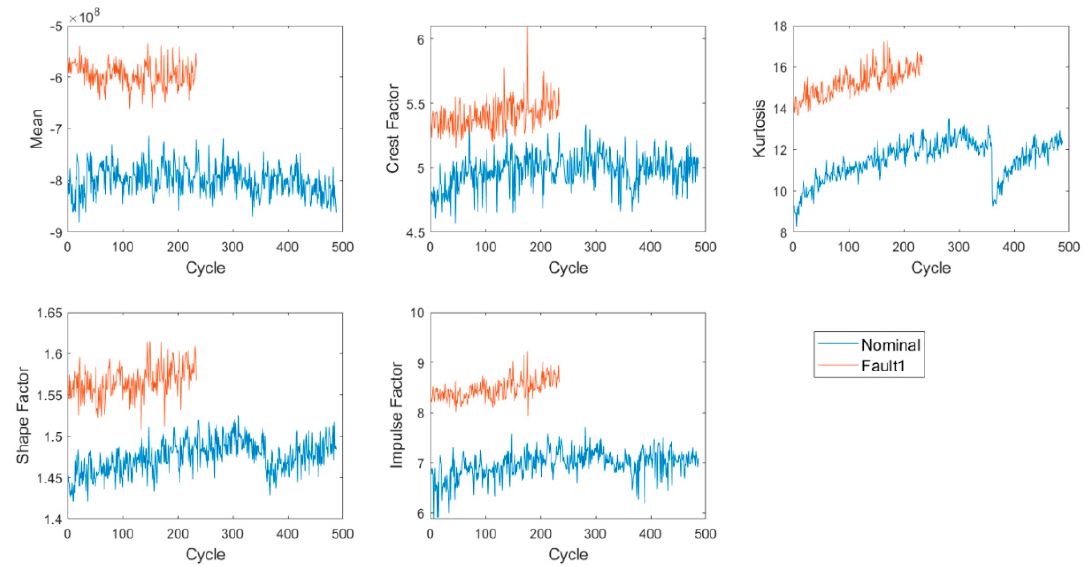
Figure 13. Selected features (sealing